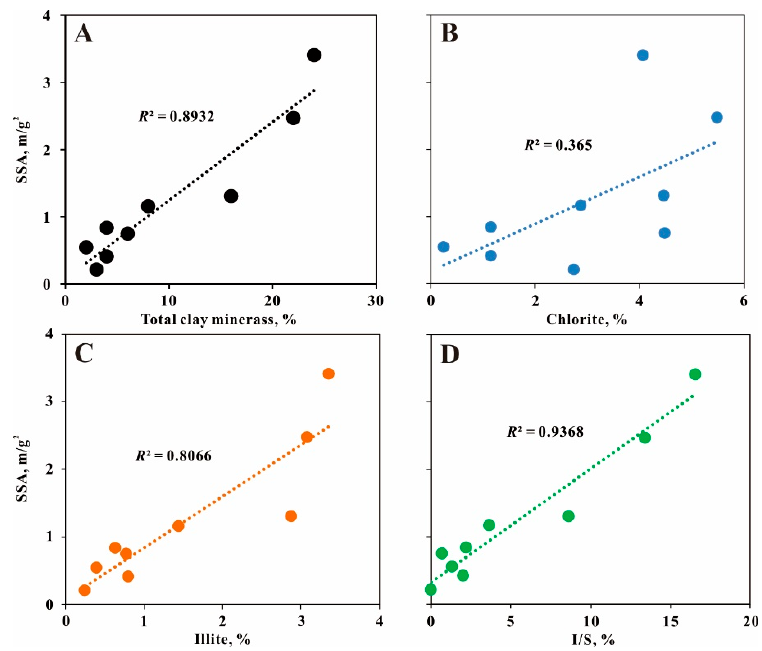
Figure 14. Positive correlations between SSA (specific surface area) derived from N 2 GA experiments and contents of total clay minerals ( A ), chlorite ( B ), illite ( C ), I/S ( D ).